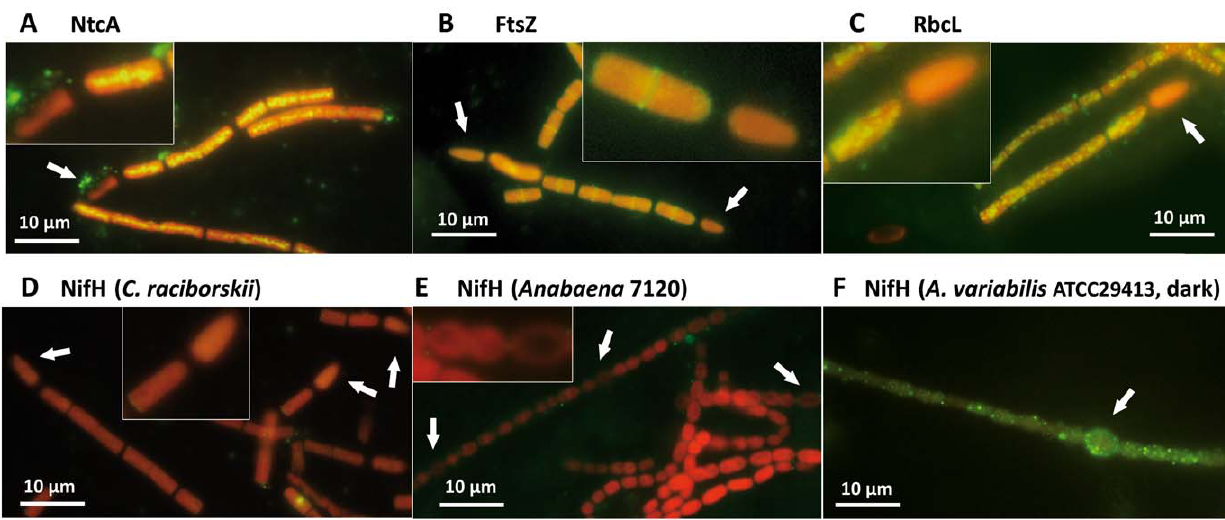
Figure 4. Immunofluorescence-LM of proteins in intact trichomes. Cultures grown in MLA 0 and a 12L/12D cycle were sampled 3 h after the beginning of the light phase. Immunofluorescence was performed on C. raciborskii using antibodies against (A) NtcA, (B) FtsZ, (C) RbcL proteins and against the NifH protein in both (D) C. raciborskii and (E) Anabaena PCC7120. (F) A. variabilis ATCC29413 grown in BG11 0 and a 12L/12D cycle was used as a positive control for NifH ( nif 2 nitrogenase) presence in vegetative cells (when sampled 4 h in the dark phase). Arrows indicate the positions of heterocysts.